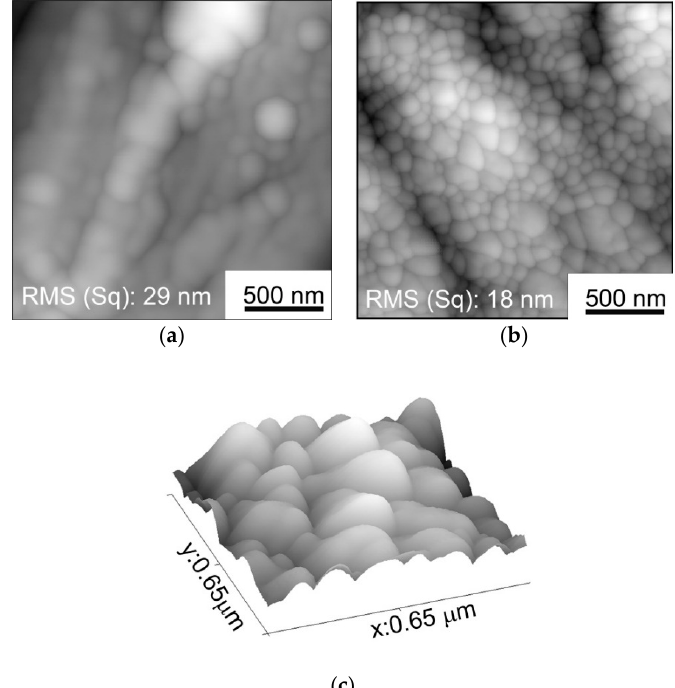
Figure 7. CaP coatings deposited on Ti at a working gas pressure of 0.8 mTorr under tilt angles of 0° ( a ) and 80° ( b ) and three-dimensional (3D) visualization of coating deposited under 80° showing the out-of-plane growth of grains ( c ).